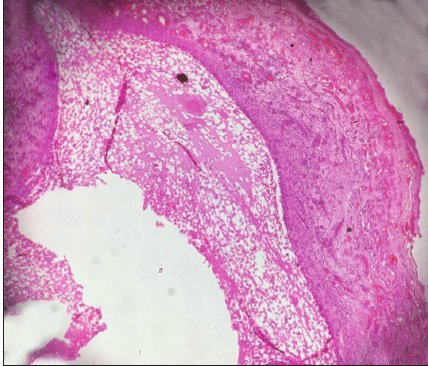
Figure 5: Photomicrograph showing H&E 40x view cystic cavity lined by thick fibrous capsule. Cystic lumen contains mucin, foamy macrophages, and chronic inflammatory cells.